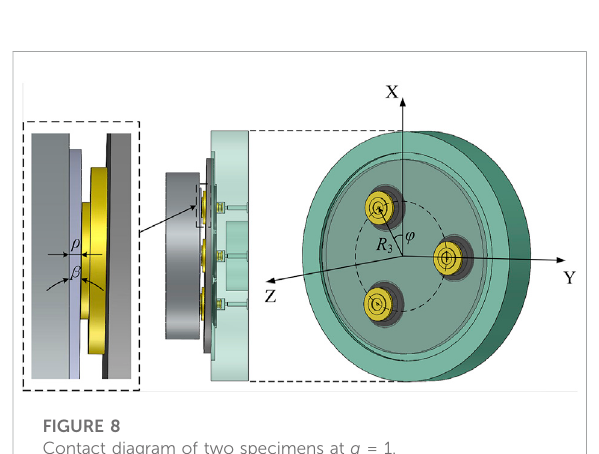
FIGURE 8 Contact diagram of two specimens at q = 1.